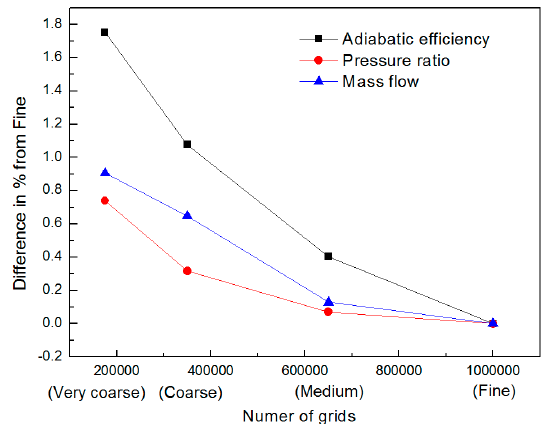
Figure 5. Results of the mesh study.